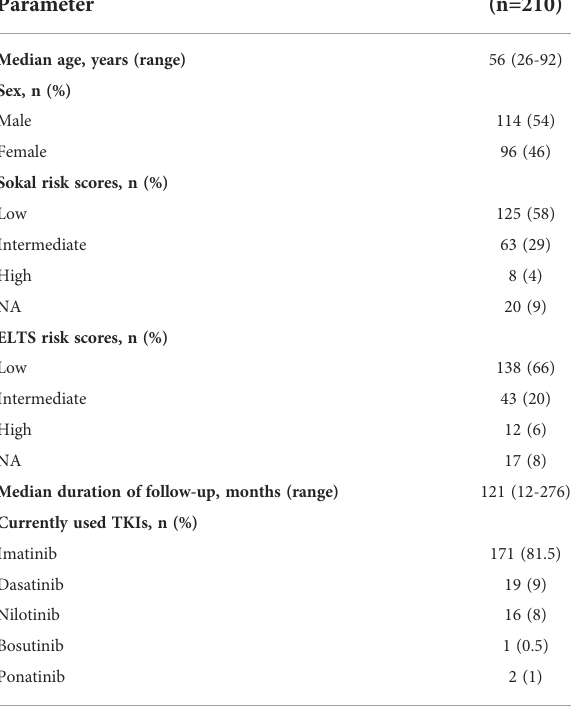
TABLE 1 The demographic and baseline features of the cohort at the onset of the pandemic.